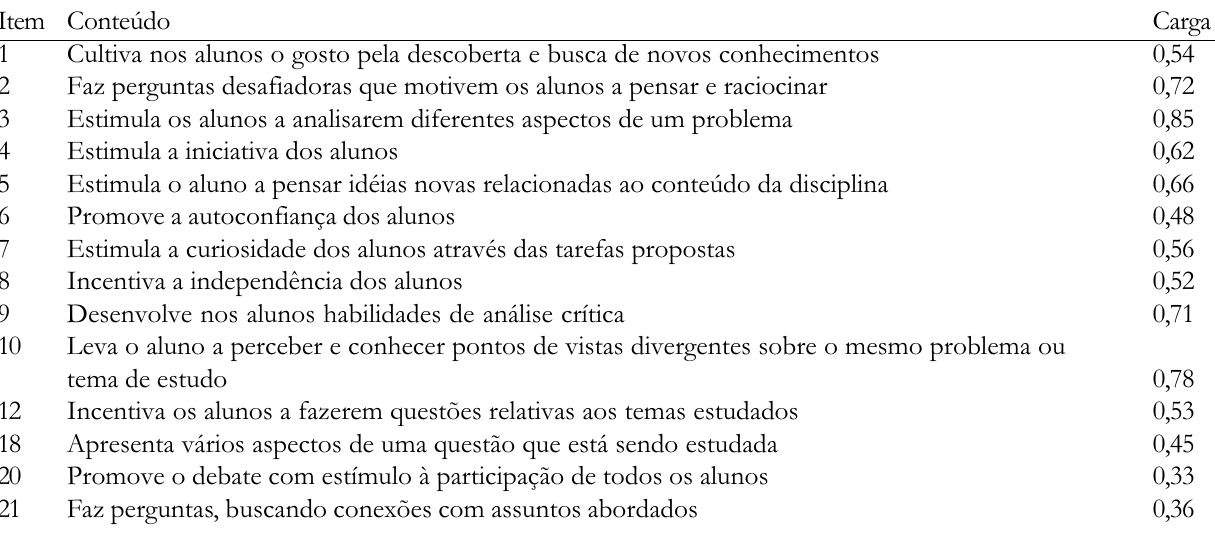
Fator 1 - Incentivo a Novas IdØias